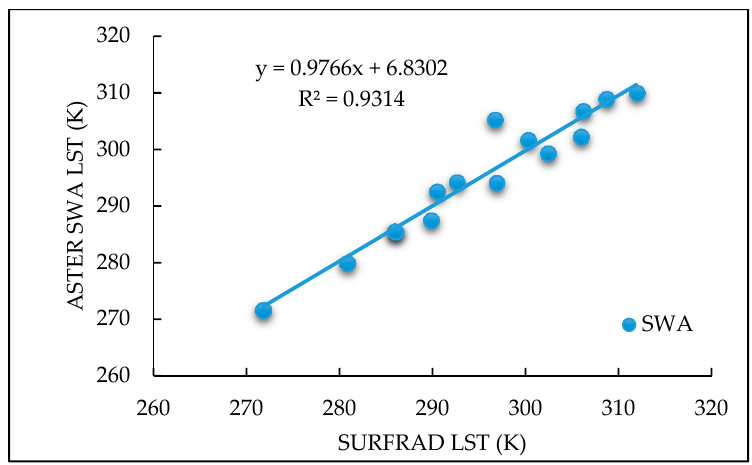
Figure 3. Comparison of scatter plots of LST inverted from ASTER data and LST derived from SURFRAD station at four SURFRAD stations: ( a ) scatter plot for LST values derived from ASTER band 13 using the SCA and the LSTs derived from SURFRAD measurements; and ( b ) scatter plot for LST values derived from ASTER band 14 using the SCA and the LSTs derived from SURFRAD measurements.